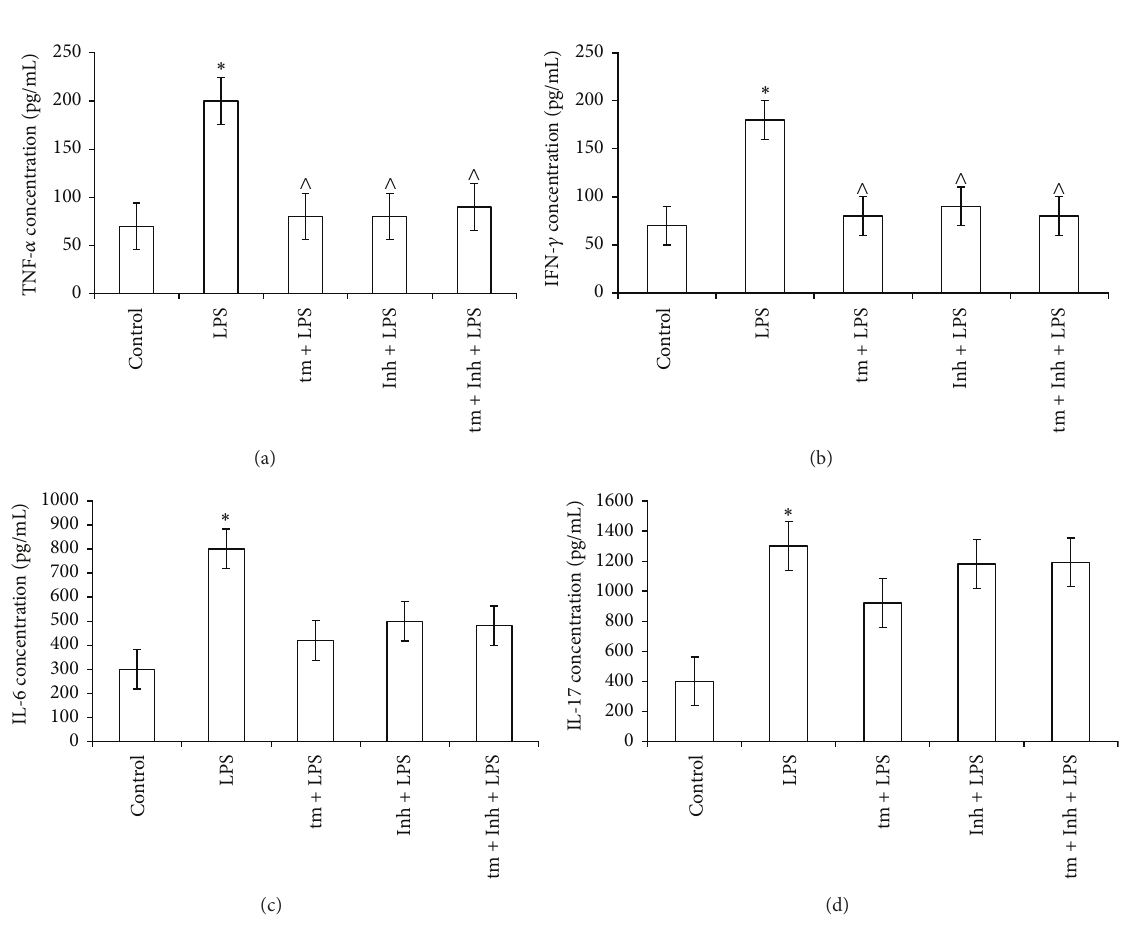
Our data show that a diet supplemented with antioxidants prevents NF- Q B activation in mice treated with LPS. It